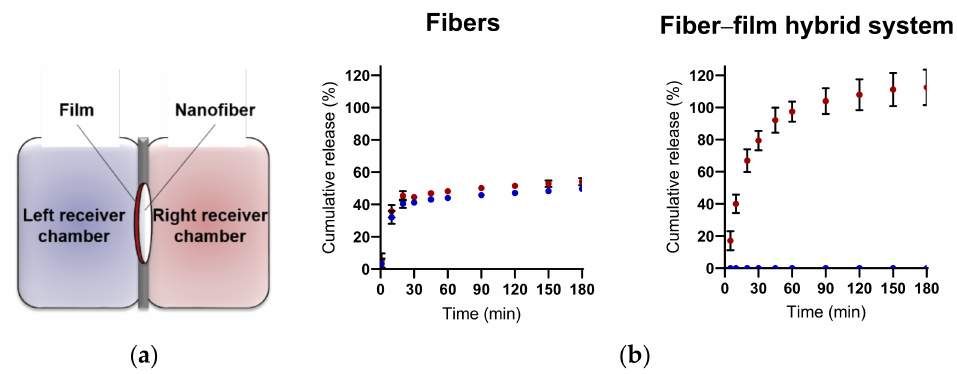
Figure 2. Nanofiber–film hybrid system facilitates unidirectional release of desmopressin. ( a ) Ex- perimental setup used for studying the release of desmopressin from the nanofibers. The release of desmopressin into both chambers (in the Ussing chamber setup) separated either by the nanofibers or by the nanofiber–film hybrid system was determined. ( b ) Release of desmopressin from nanofibers or the nanofiber–film hybrid system in the left (blue) and right (red) Ussing chamber, respectively, as depicted in ( a ). The cumulative release was based on a loading of 8% ( w / w ) desmopressin in the chitosan/PEO nanofibers. The data are presented as mean ± SD. N = 3, n = 2–3, where N represent the number of individually prepared nanofibers/hybrid systems and n is the number of measurements per